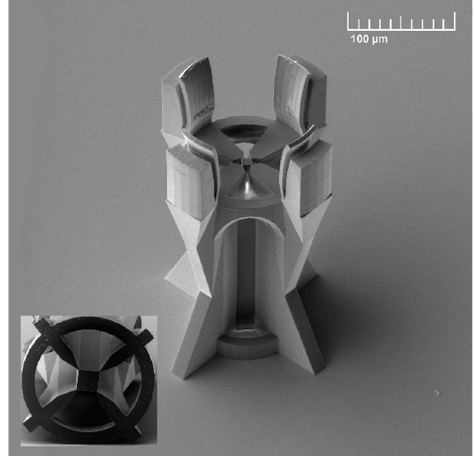
Figure 7. SEM image of the fabricated 1 × 4 MMI splitter with square-profile tapered input waveguide and the supporting structure. Inserted image shows the detail of the output side of the splitter.